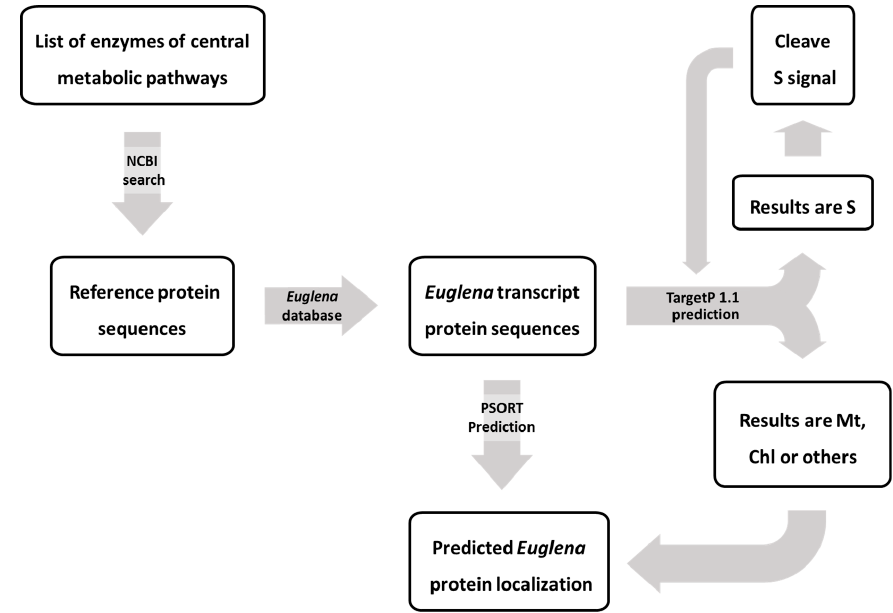
Figure 3. Subcellular location prediction workflow for Euglena proteins. Abbreviations: Mt—mitochondria;